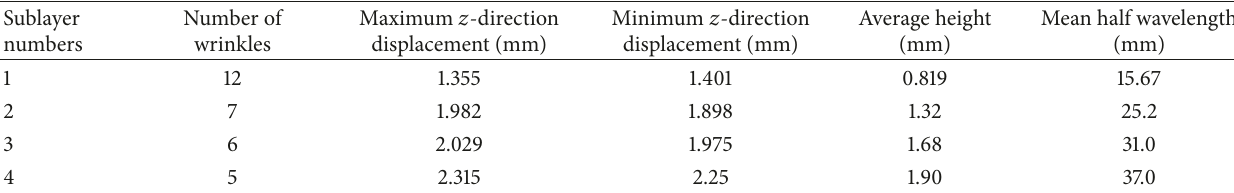
Table 13: The geometrical features of different ply numbers laminated membranes.